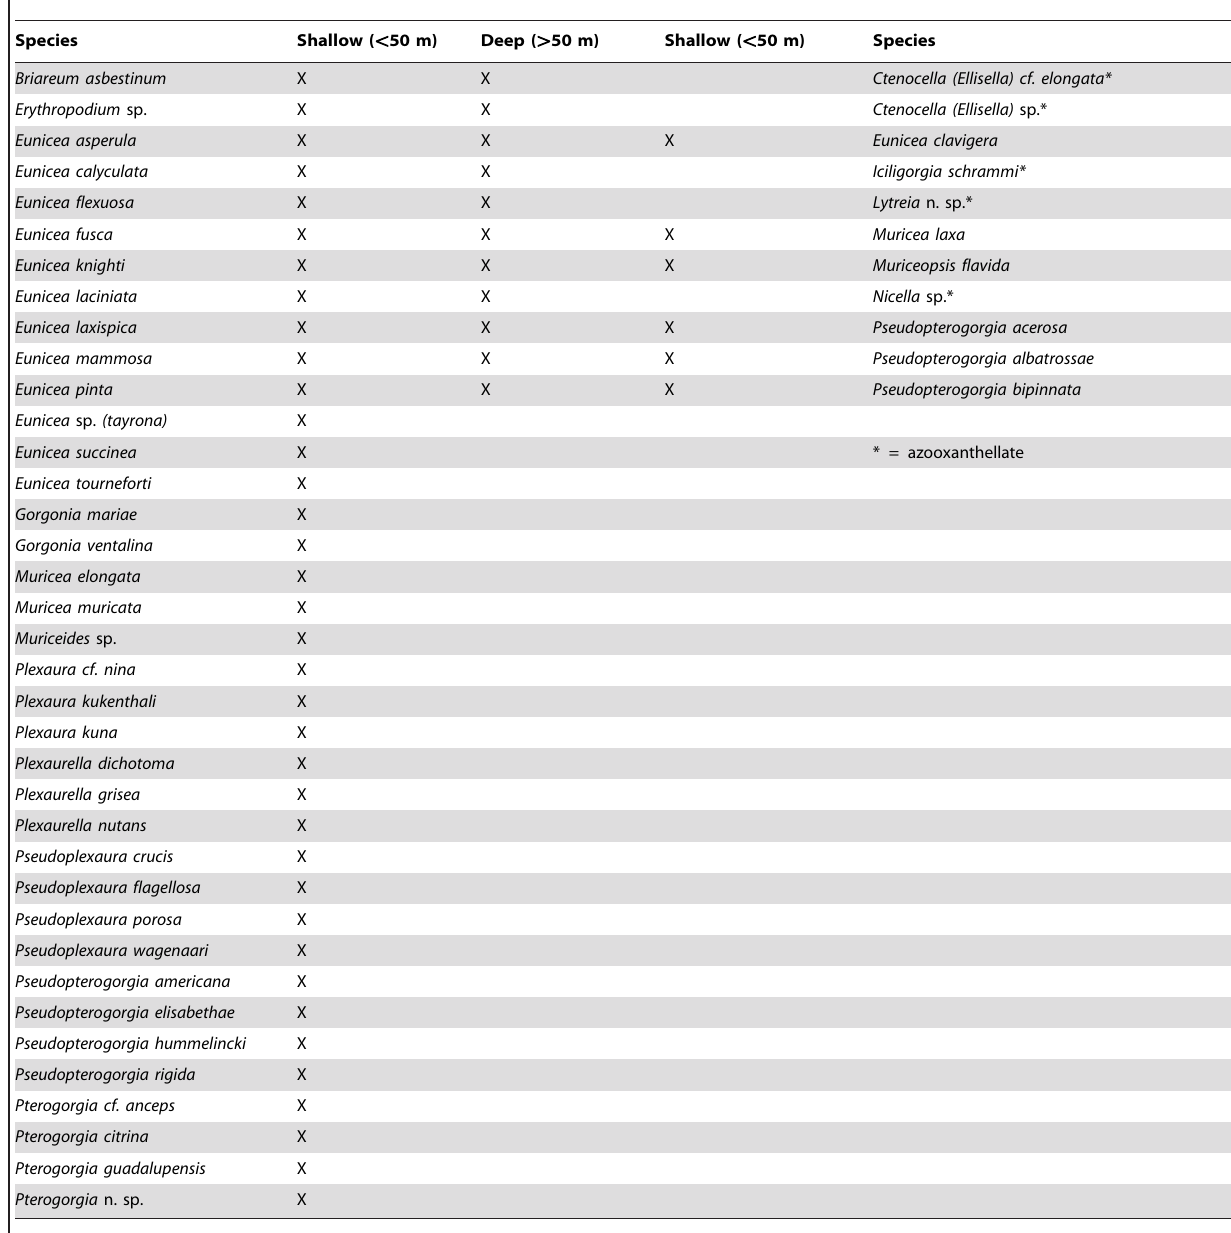
Species Shallow ( , 50